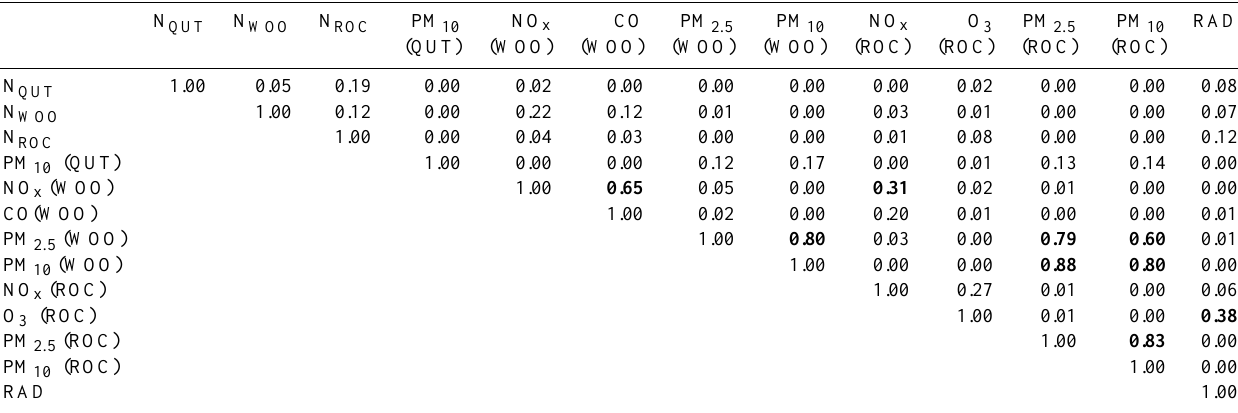
Fig. 4. Wind rose plots of (a) relative PNC contribution at QUT, WOO and ROC; (b) relative frequencies of wind direction. Table 1. r 2 calculated between the